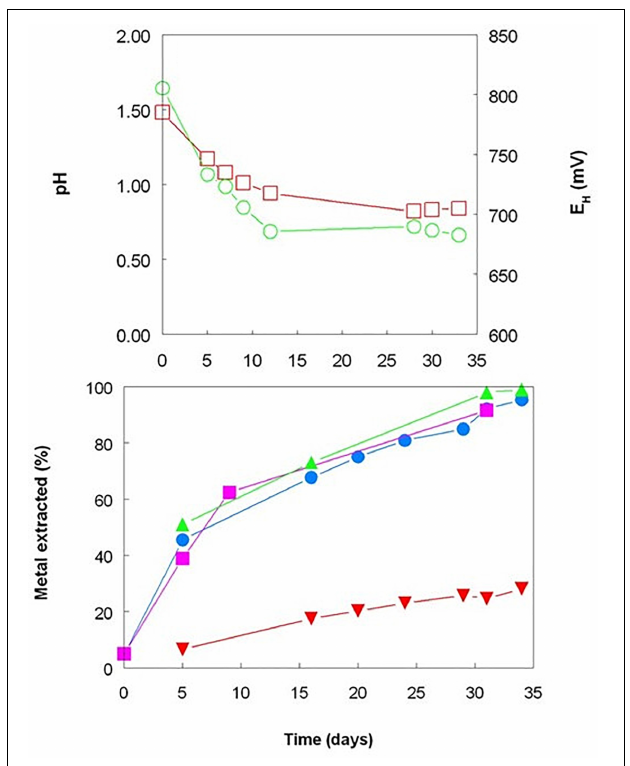
FIGURE 3 | Changes in pH ( (cid:3) ) and redox potentials (o), and concentrations of total soluble of cobalt ( ), manganese ( ), nickel ( (cid:78) ), and iron ( (cid:72) ) during bioleaching of Shevchenko limonite by a pure culture of Acidithiobacillus (cid:32)